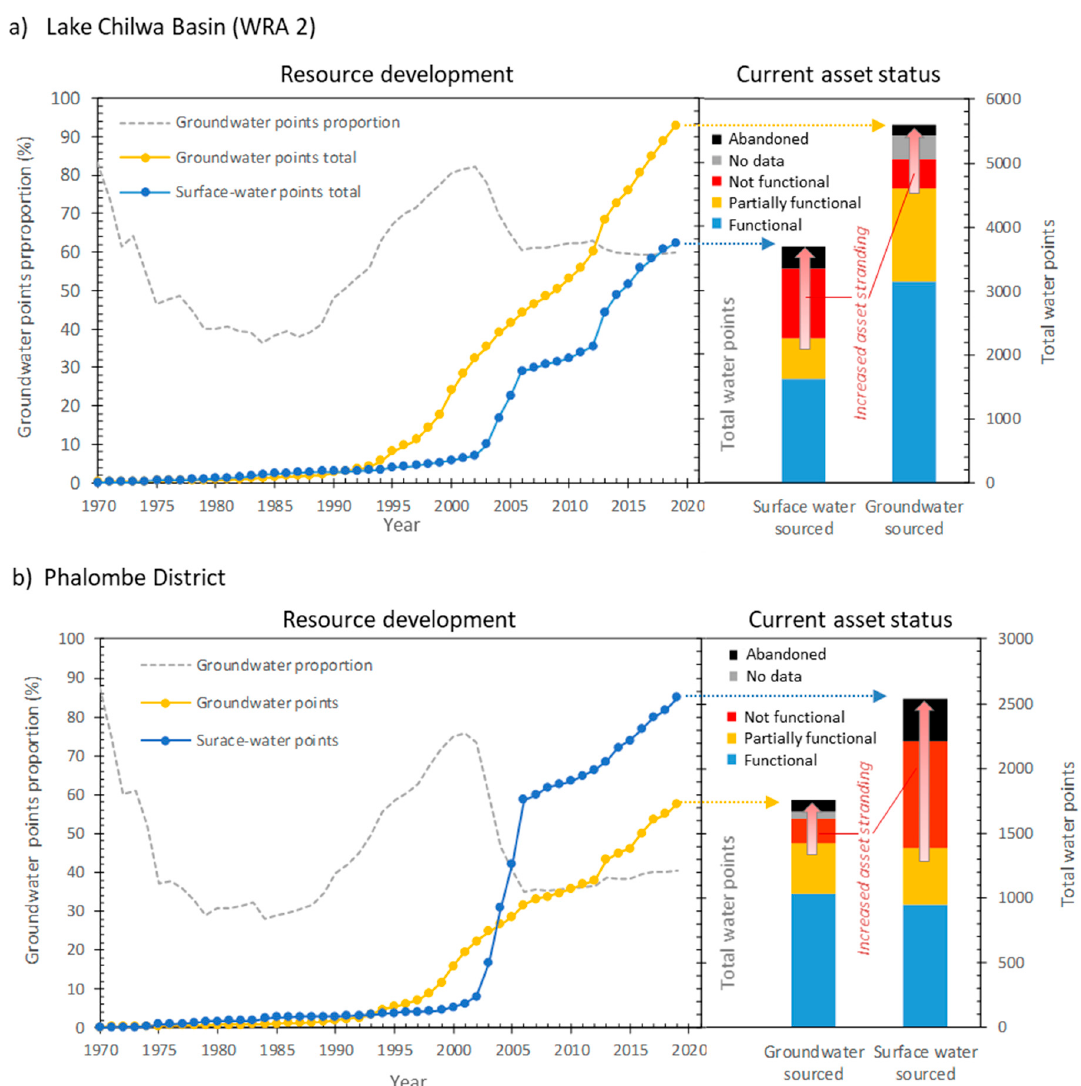
Figure 12. ( a ) Lake Chilwa Basin (Water Resource Area 2) and ( b ) Phalombe District: cumulative historical development of groundwater and surface water water points (secondary y axis, far right) and percent proportion of groundwater points (primary y axis); and current asset status showing functionality breakdown of total points surveyed in 2019 (based on mWater data retrieval May, 2020).